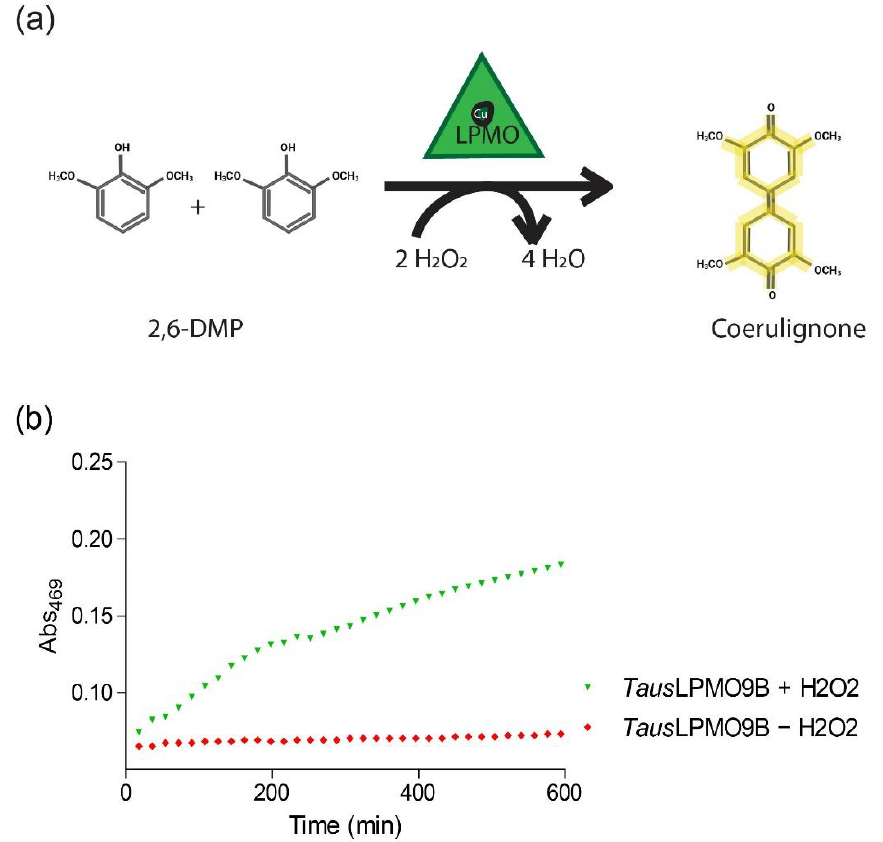
Figure 8. DMP assay to measure LPMO activity. ( a ) In the presence of H 2 O 2 , LPMOs catalyze the conversion of 2,6-DMP to coerulignone, a chromogenic compound with a maximum absorption at 469 nm. ( b ) Taus LPMO9B [47] activity with DMP in the presence (green) or absence (red) of H 2 O 2 . Reactions were run at 30 °C and contained 0.06 mg/mL purified LPMO, 10 mM substrate, and 1 mM H 2 O 2 in a 100 mM sodium acetate buffer pH 4.5.